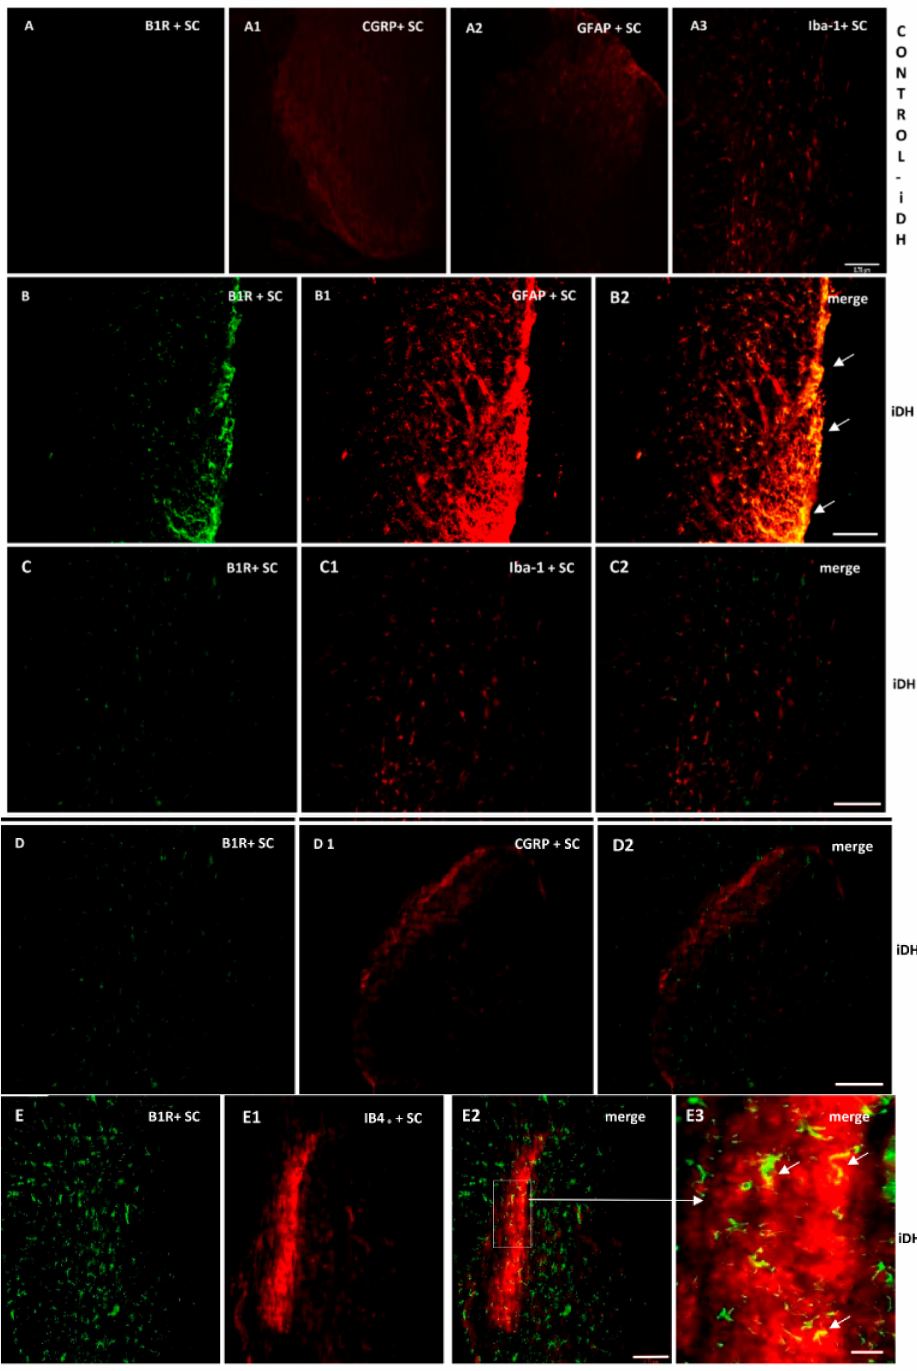
Figure 5. Cellular distribution of B1R in the ipsilateral Dorsal Horn (iDH). Representative microphotographs by immunofluorescence of B1R (green, B – E ) relative to GFAP (red, B1 ), Iba-1 (red, C1 ), CGRP (red, D1 ) and IB4 + (red, E1 ) in the spinal cord (SC) of PSNL rats. Control spinal cord for B1R (A) expression exhibits very weak-to-no signal. Expression of CGRP ( A1 ), GFAP ( A2 ) and Iba-1 ( A3 ) is moderate in the spinal cord of control animals. B1R immunolabelling is colocalized with astrocytes (arrows, GFAP, B2 ) and non-peptide fibers (arrows, IB4 + , E2 , E3 ), but not with microglia (Iba-1, C2 ) and peptide fibers (CGRP, D2 ) in the spinal dorsal horn of PSNL rats. E2 is enlarged in E3 as indicated by the white square and arrow. Scale bar = 120 µ m (all panels, 10 × ), except 60 µ m ( E3 , 20 ×